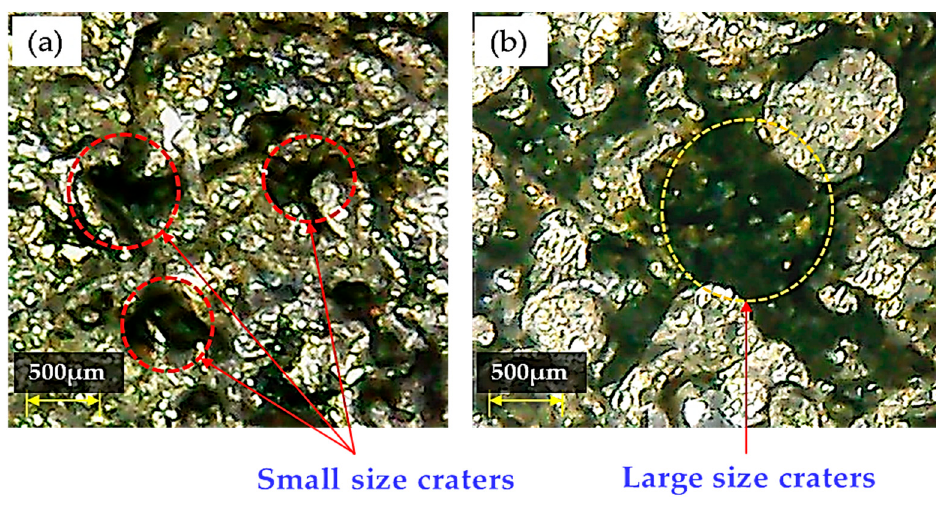
Figure 16. Micrographs showing the different sizes of craters present on workpiece’s surface ma- chined witha brass tool: ( a ) small size craters generated for DC = 8 A and positive polarity; ( b ) large size craters generated for DC = 10 A and negative polarity.